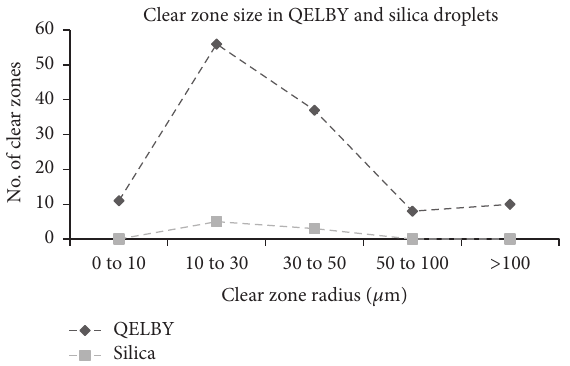
Figure 5: Clear zone size distribution in a QELBY suspension compared to a reference silica